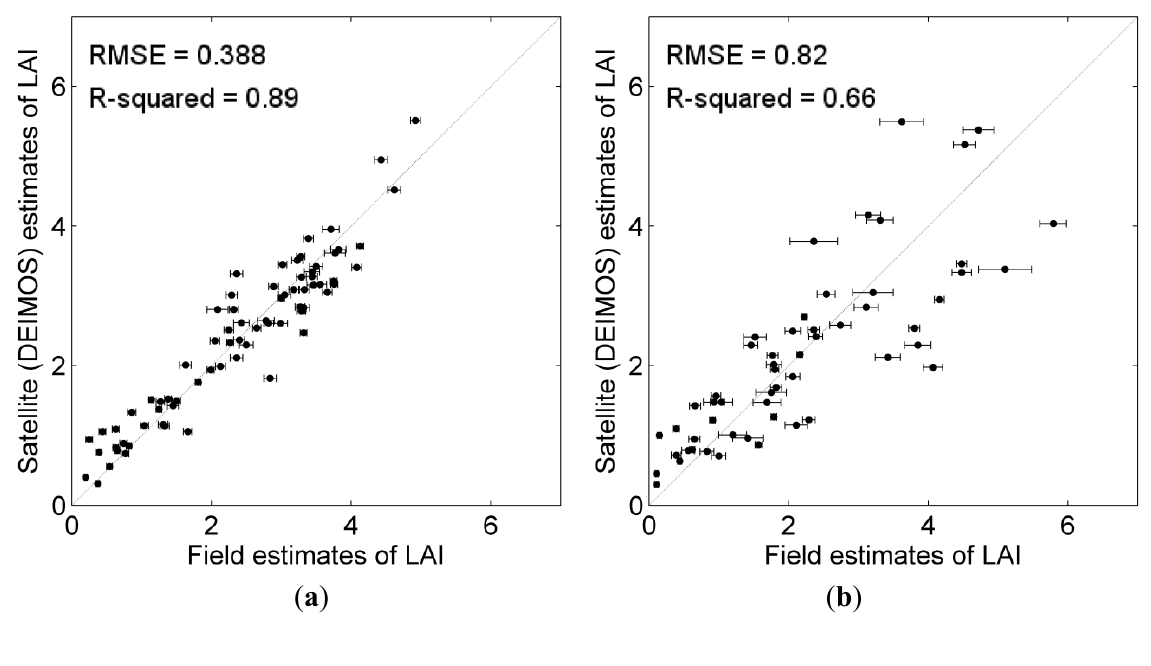
Figure 4. Procedure 2: scatterplots of the LAI estimation for the Italian case study ( a ) and for the Austria case study ( b